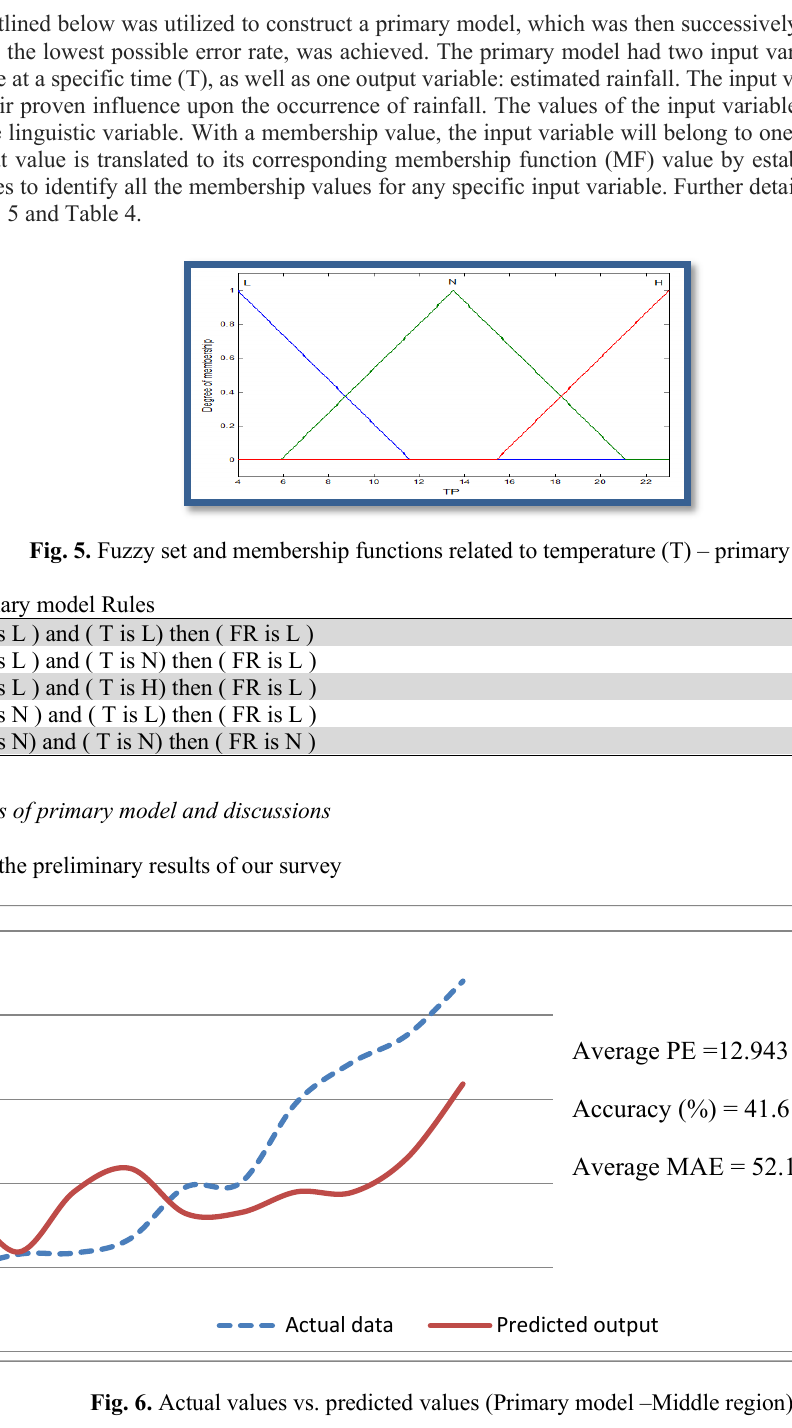
Fig. 4. Fuzzy Logic Modeling Procedures: A. Modeling Procedures, B. Performance Evaluation